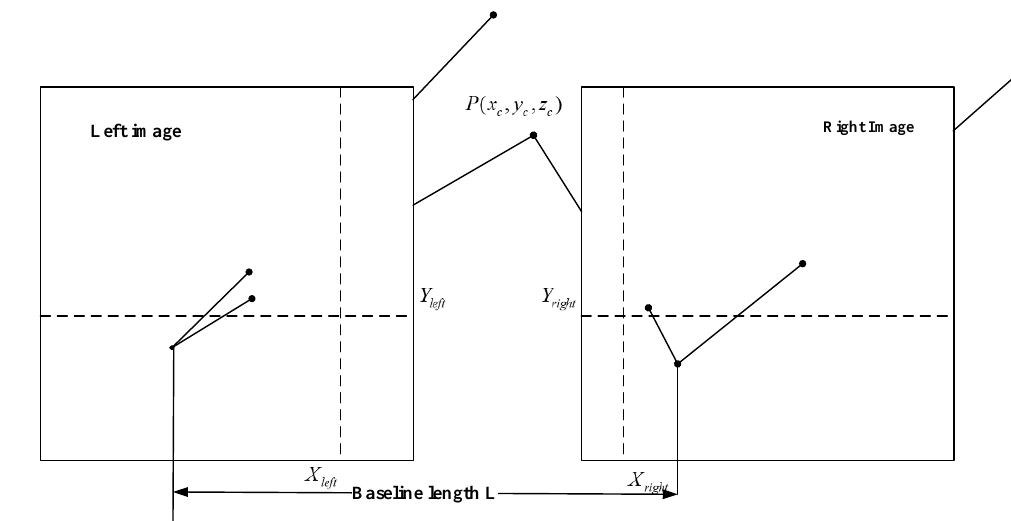
Figure 2. Schematic diagram of binocular stereo vision imaging. From trigonometric geometry, we have